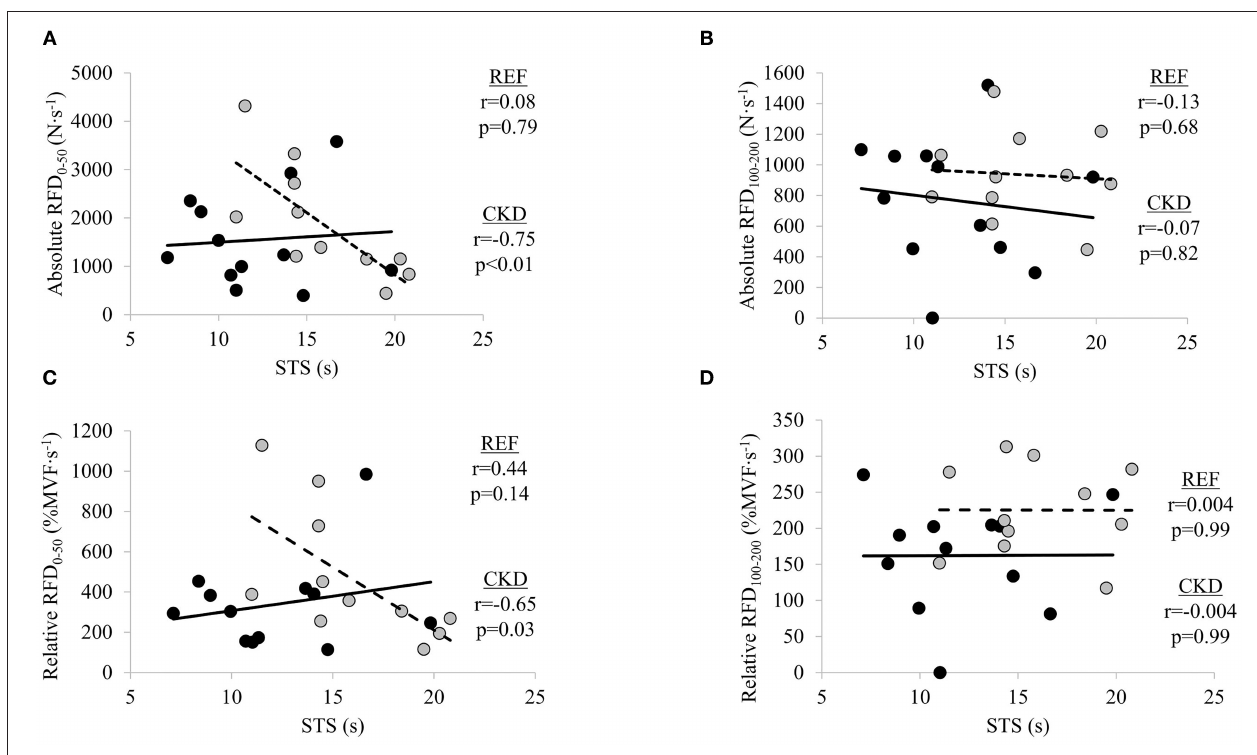
FIGURE 2 | Relationships between absolute rate of force development (RFD) and sit-to-stand (STS) at time intervals (A) 0–50ms and (B) 100–200ms, and relative RFD and STS at time intervals, (C) 0–50ms and (D) 100–200ms. Gray circles and dashed lines represent patients with chronic kidney disease stages (CKD) 3b and 4 not on dialysis (CKD) while solid circles and lines represent reference participants (REF). N · s − 1 , Newtons per second; % MVF · s − 1 , percent maximal voluntary force per second; s , seconds. Significance level set at p ≤